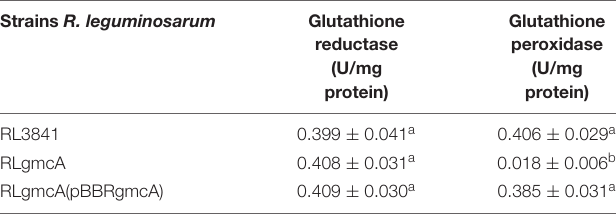
TABLE 3 | Oxidase activity of R. leguminosarum gmcA